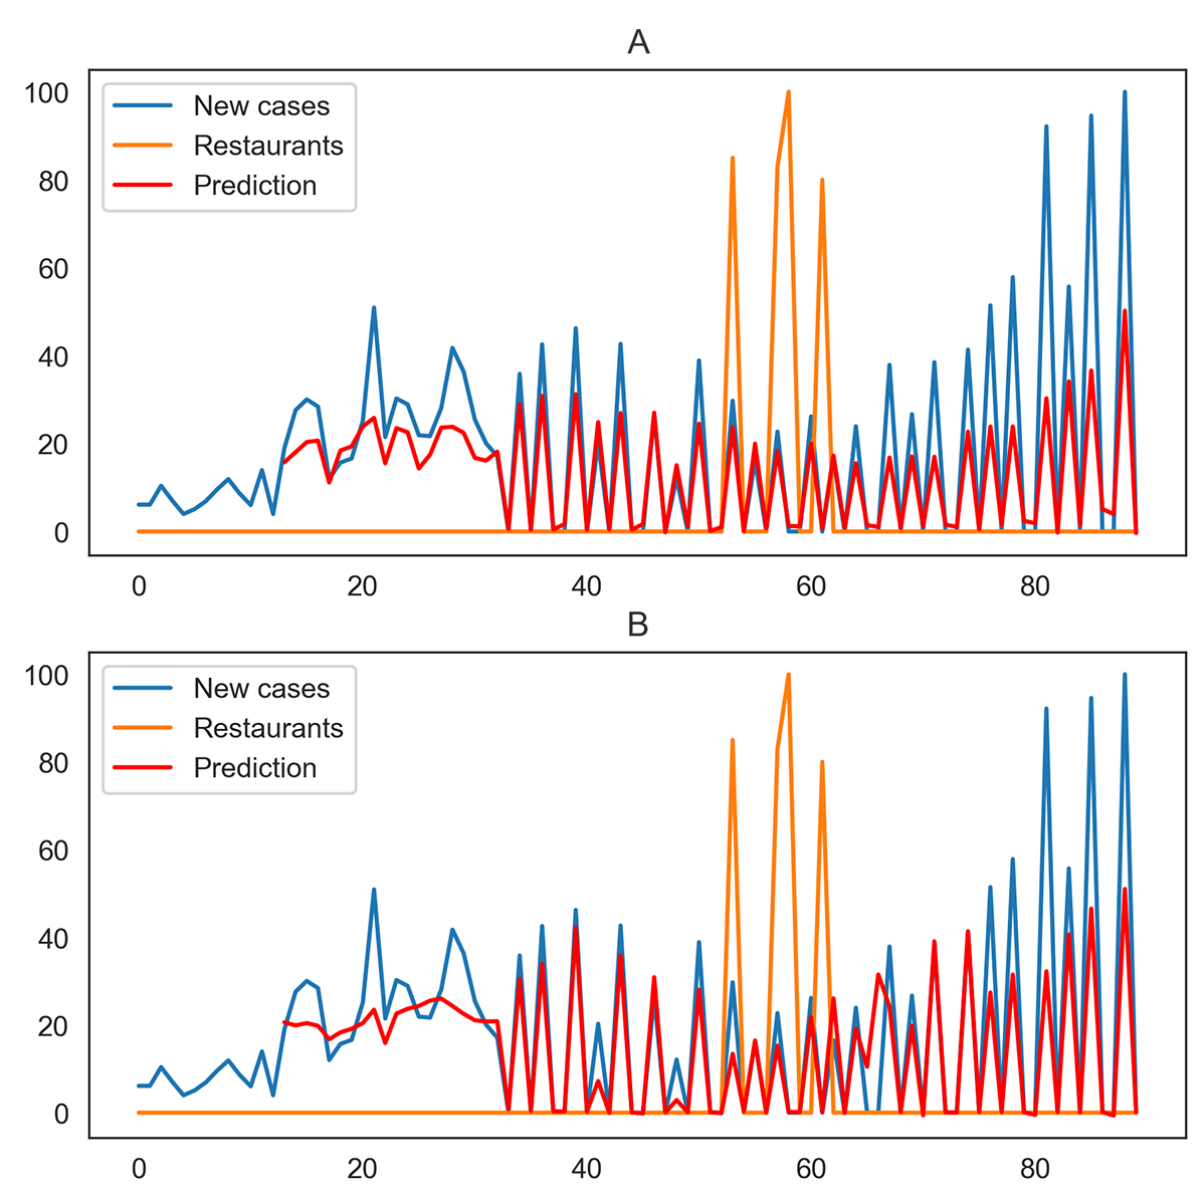
Figure 5. Prediction values for daily new cases of COVID-19 without (A) and with (B) restaurant search trends for Kansas from April 9 to July